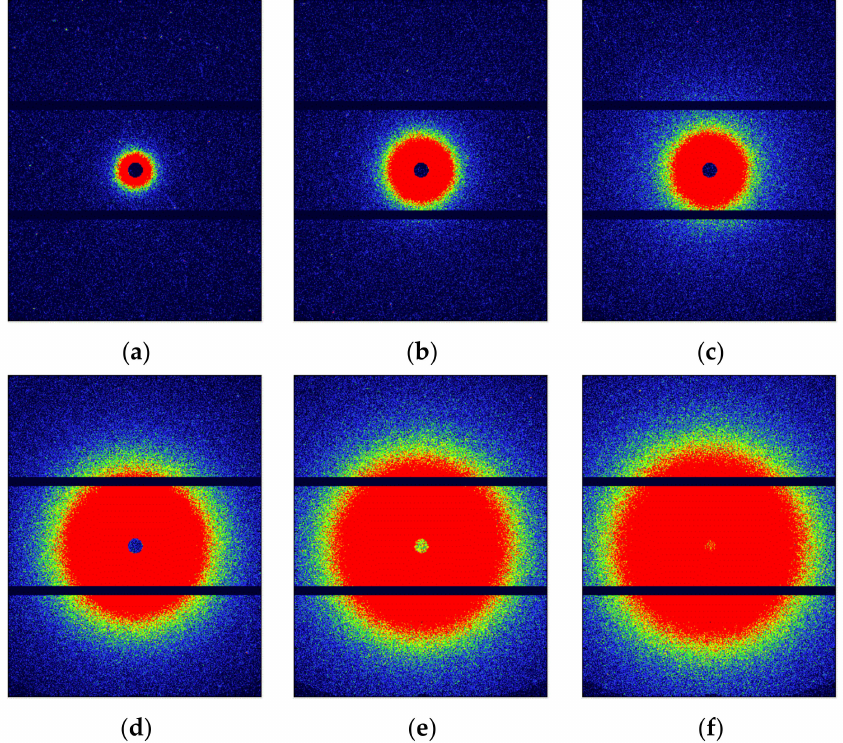
Figure 3. SAXS patterns of CL-20 after heating under different temperatures at different times: ( a ) 30 ◦ C; ( b ) 170 ◦ C; ( c ) 200 ◦ C immediately; ( d ) 200 ◦ C after 118 min; ( e ) 200 ◦ C after 198 min; ( f ) 200 ◦ C after 278 min. All the SAXS patterns are on the same strength